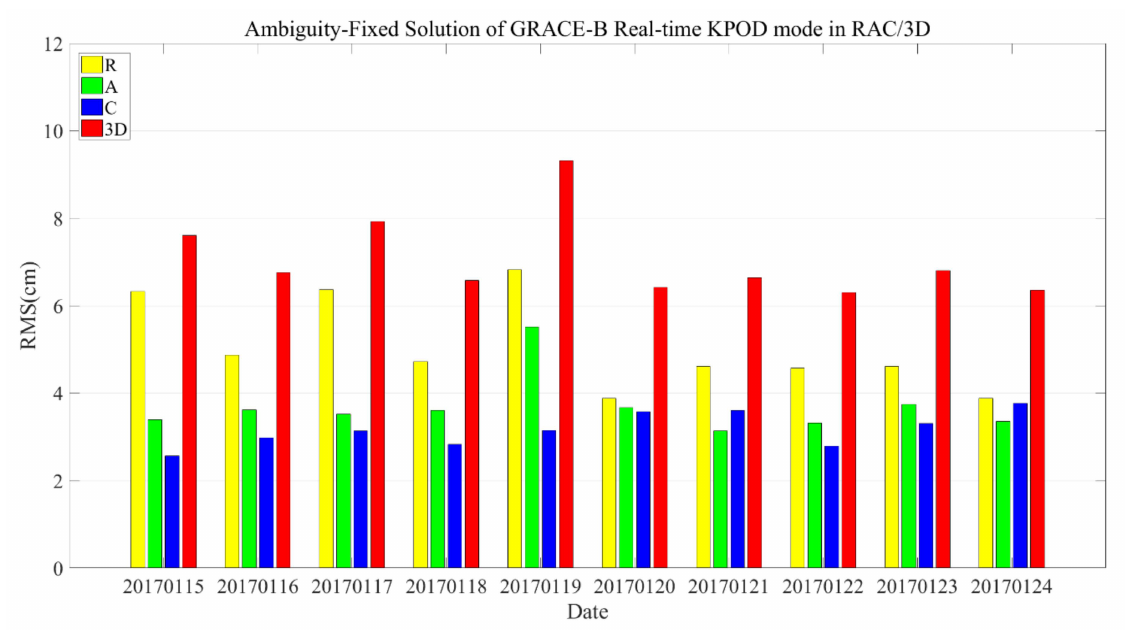
Figure 6. The accuracy (RMS) of real-time KPOD ambiguity-float ( upper ) and ambiguity-fixed ( bottom ) solution for GRACE-B.